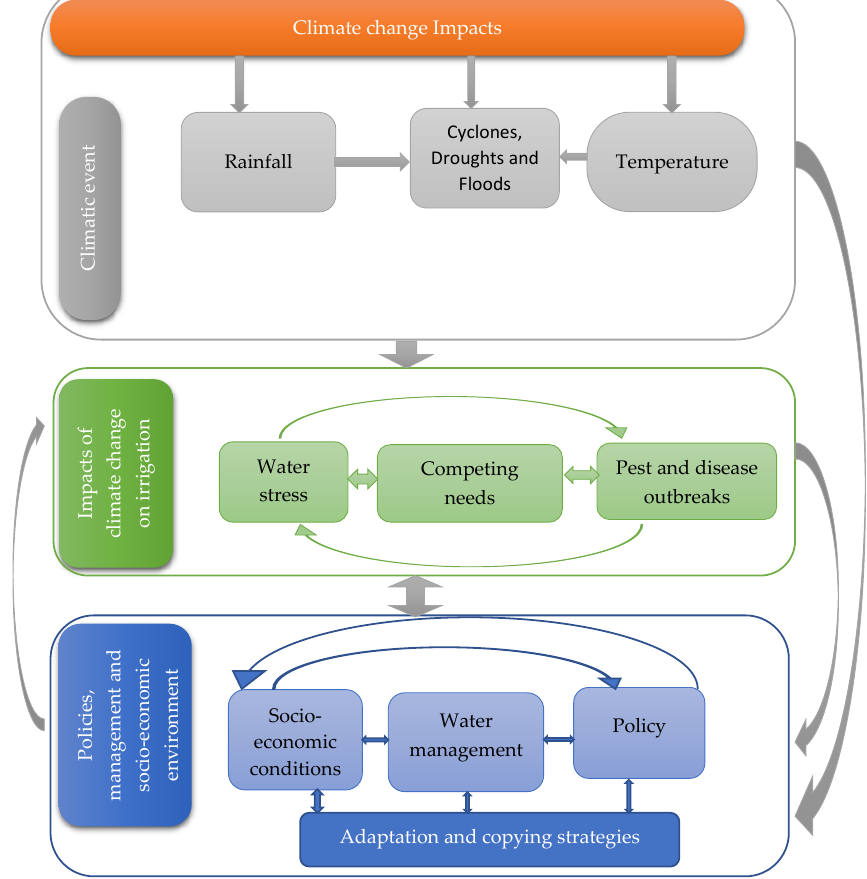
Figure 2. Flowchart of proposed interaction of climatic, ecological and social factors.